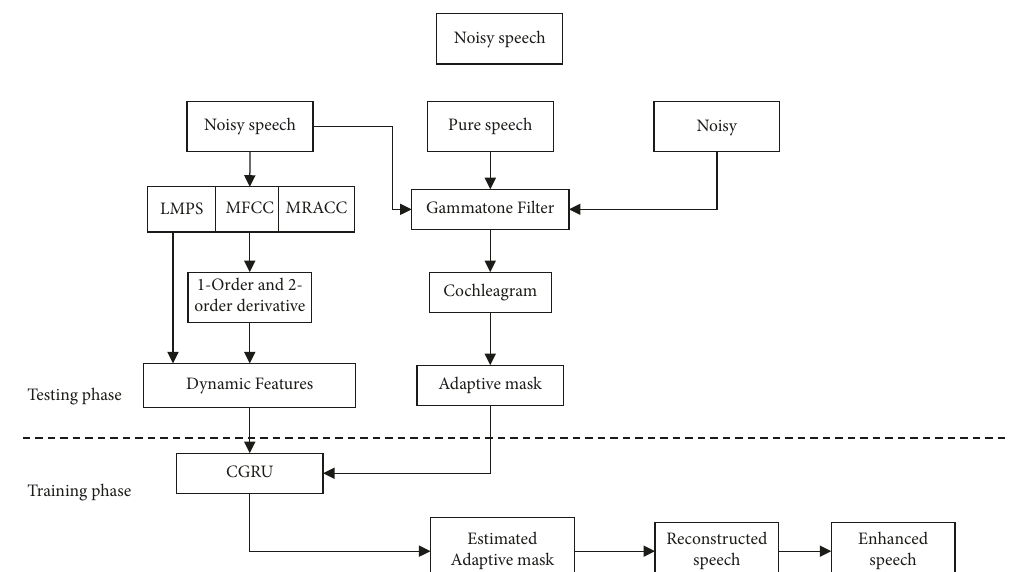
Figure 5: Block diagram of a neural network speech enhancement system based on dynamic features and adaptive